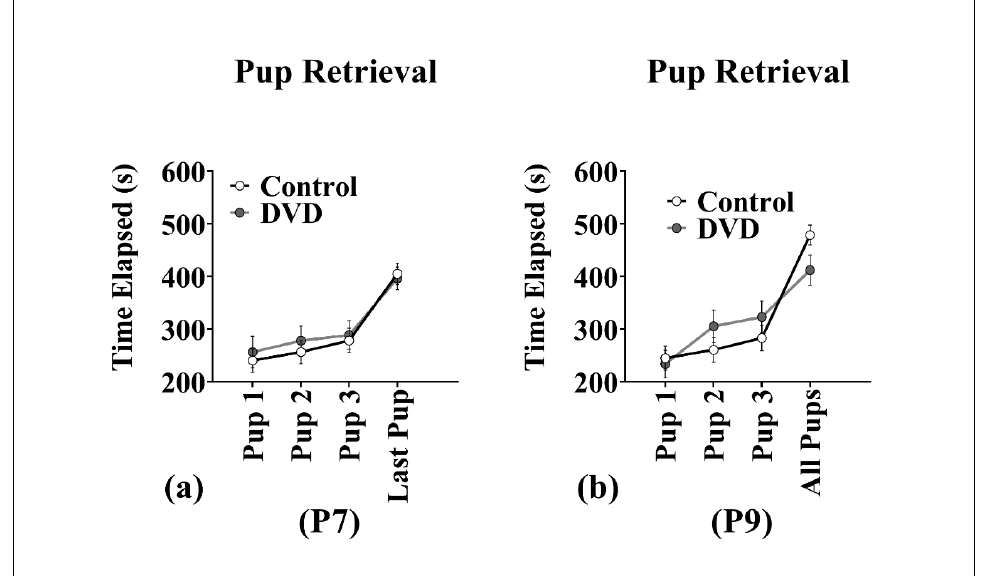
Figure 3. Pup retrieval assay (Cohort 1) . Pup retrieval behavior in vitamin D deficient and